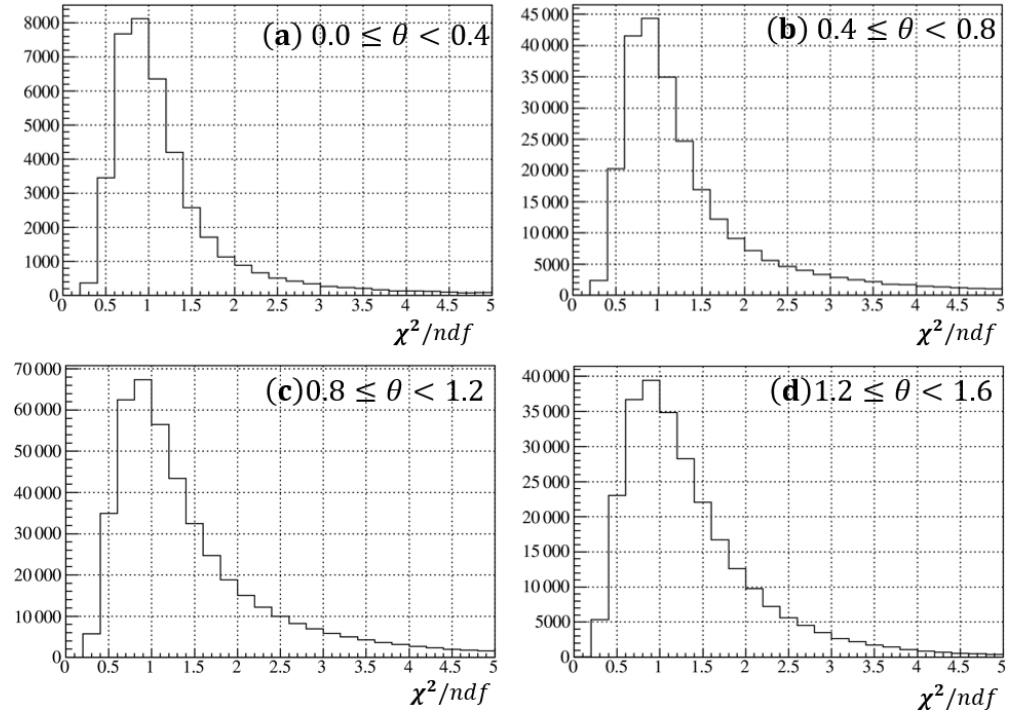
(cid:113) tan 2 θ x + tan 2 θ y in an ECC. (a) 0 ≤ θ < 0 . 4, (b) 0 . 4 ≤